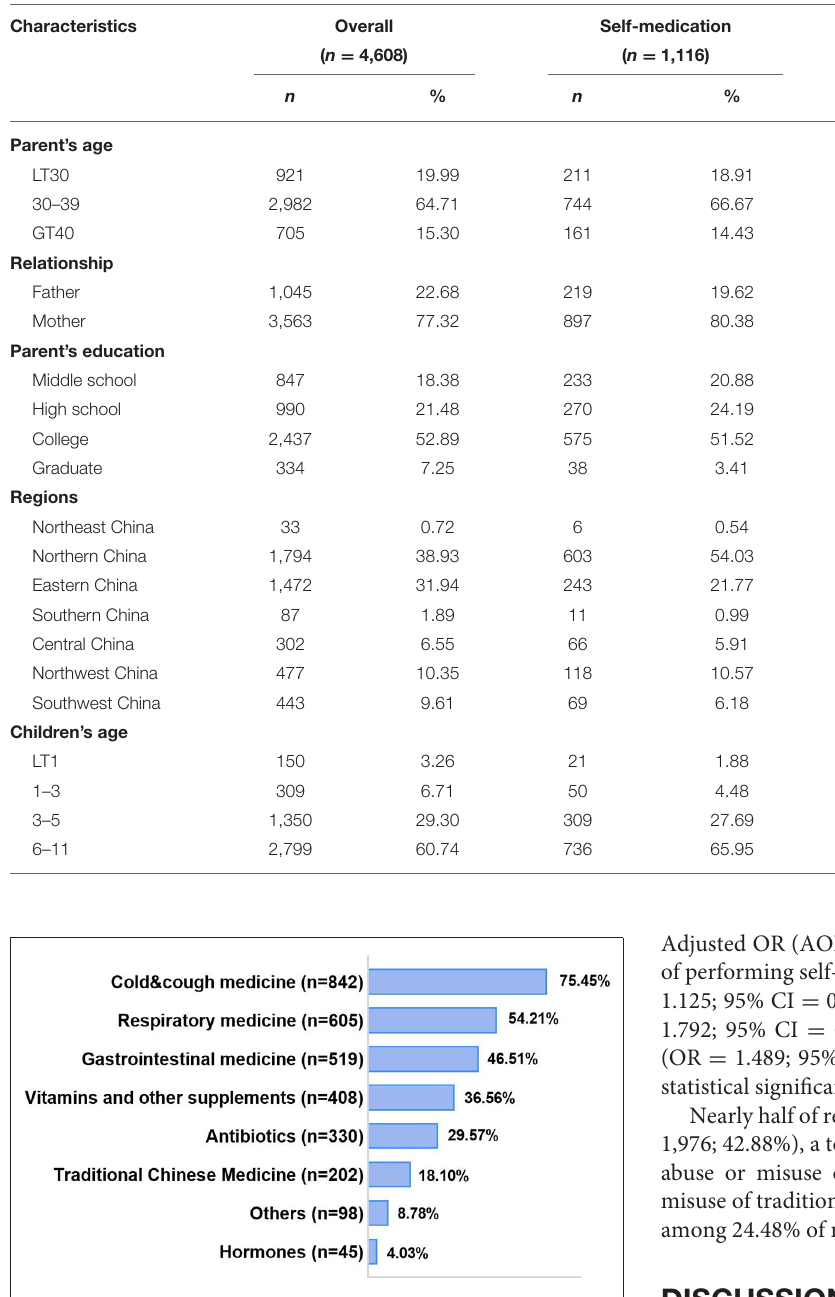
FIGURE 1 | Use of self-medication